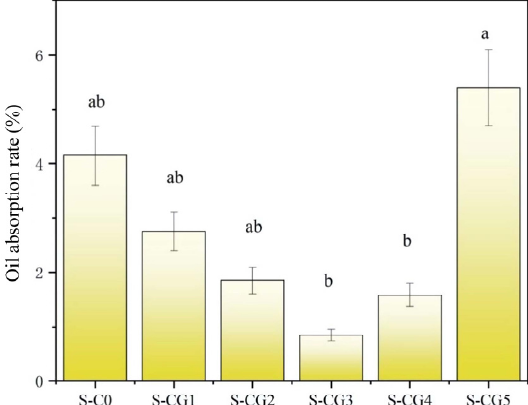
Figure 8. The oil absorption of composite films. Results are expressed as average, and different letters (a, b) indicate significant differences ( p < 0.05).